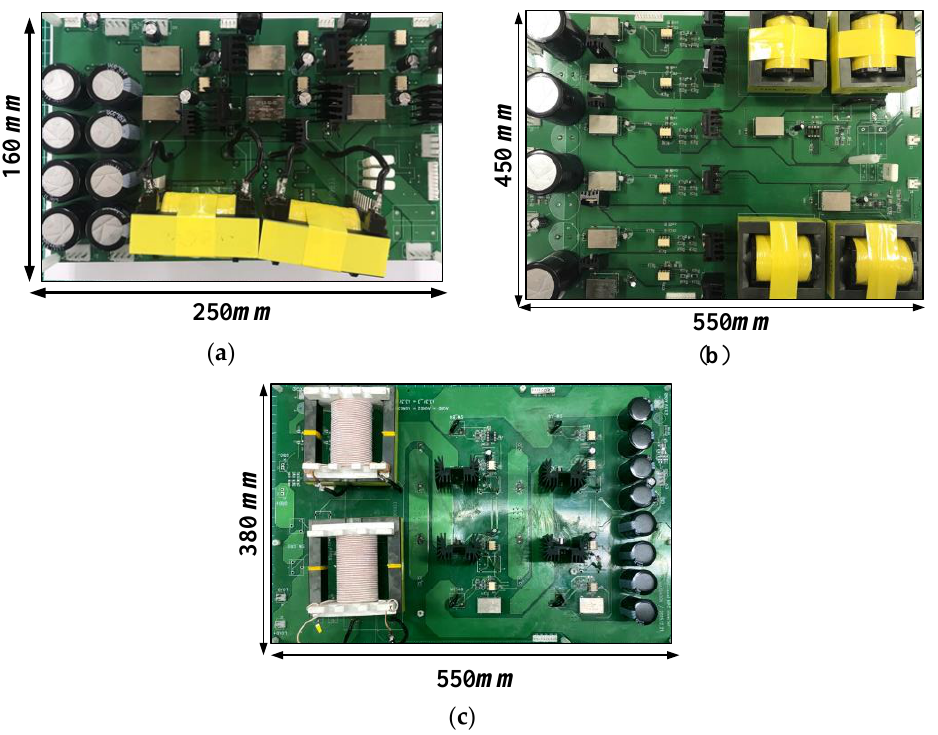
Figure 9. Photographs of the experimental inverters: ( a ) proposed inverter, ( b ) interleaved dual buck inverter (IDBI), and ( c ) full bridge inverter (FBI). Table 3. Components for the experimental inverters.